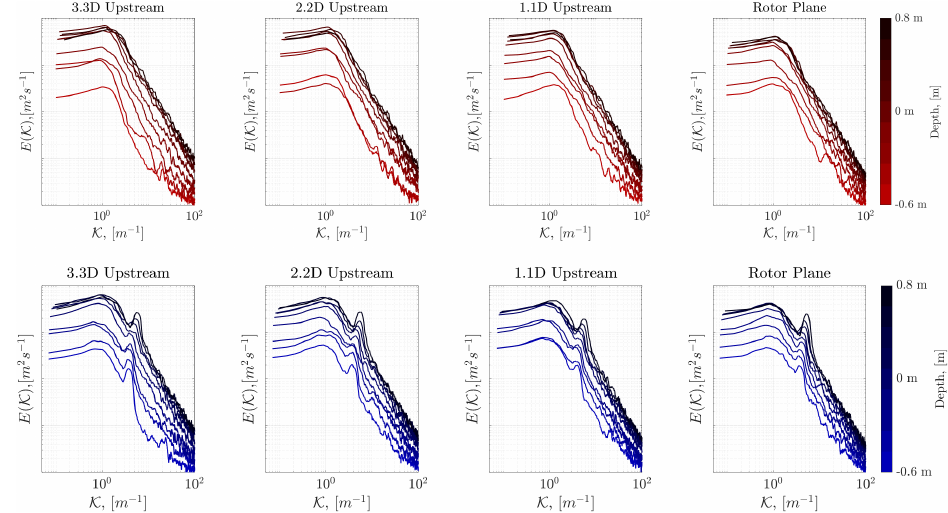
Figure 6. PSD plot for each fluid velocity time series captured. Upper plots show the CO cases, whereas lower plots show the JSP cases. The colour bars to the right of the charts indicate the corresponding depths.